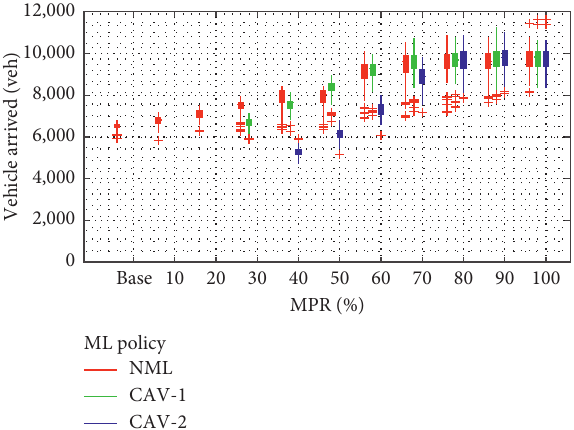
Figure 12: Network throughput.